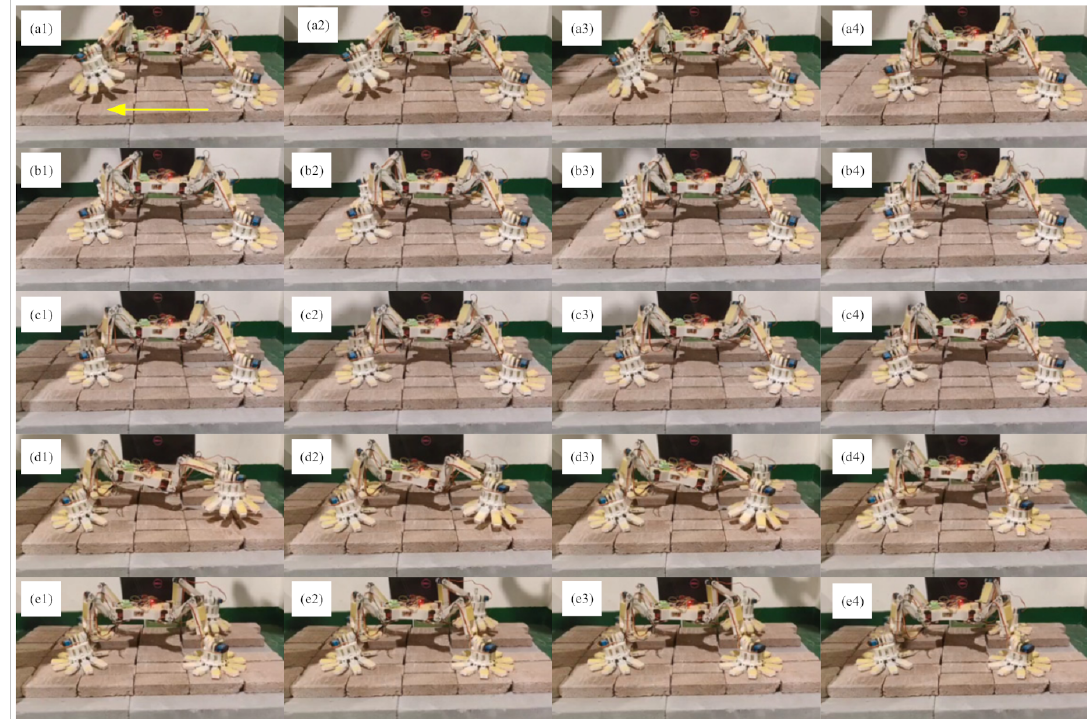
swinging the right front leg, moving the fuselage forward, swinging the left rear leg, and swinging the right rear leg. In general, the asteroid-exploration robot walked smoothly. Before each leg lift, the anchor mechanism released the ground. After the leg completed the swing phase, the anchoring mechanism gripped the ground again.